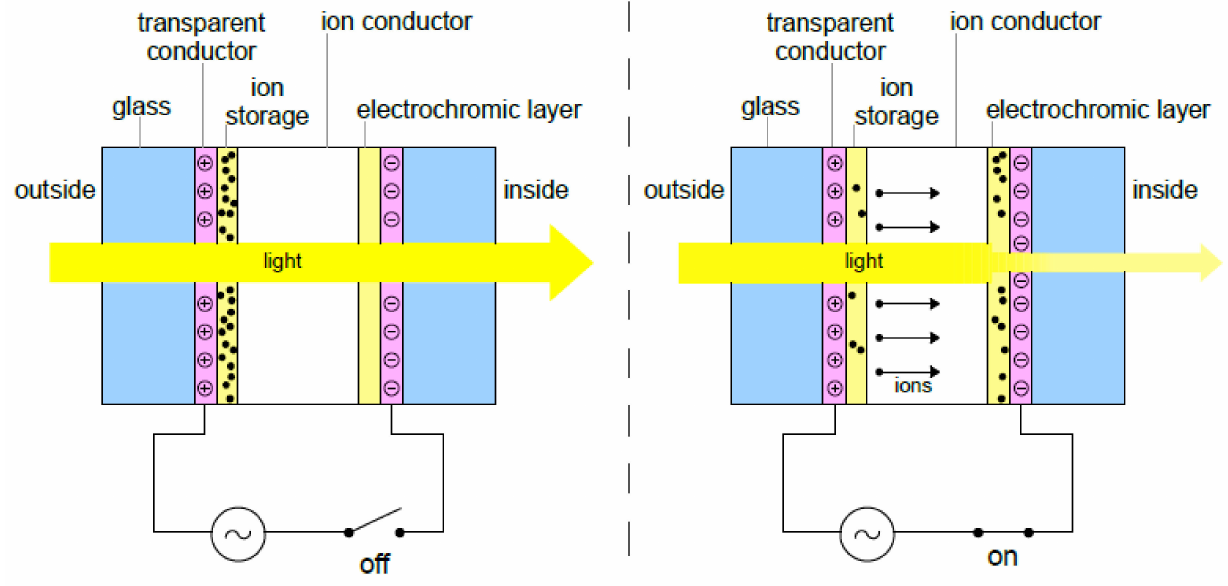
Figure 1. Electrochromic glazing schematic